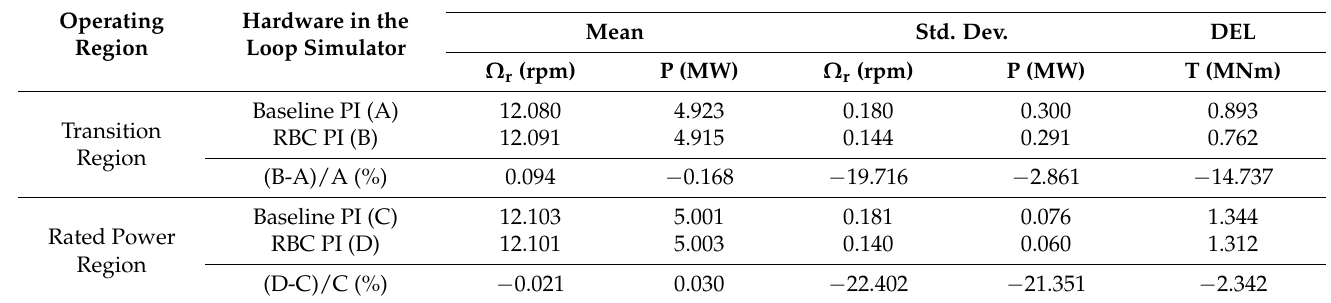
Table 2. Quantitative comparison of control performance for NREL 5MW wind turbine during HILS